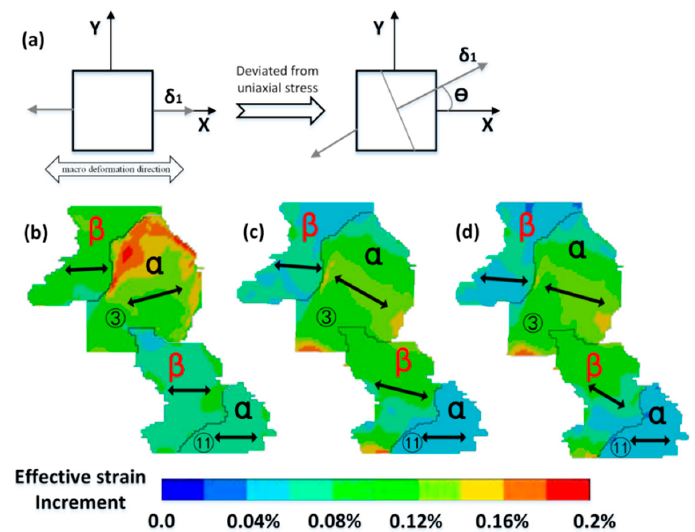
Figure 12. ( a ) Schematic diagram of major principal stress; ( b ) ε = 0.7%; ( c ) ε = 2.4%; ( d ) ε = 7.8% effective strain increment fields in the local and the direction of major principal stress.